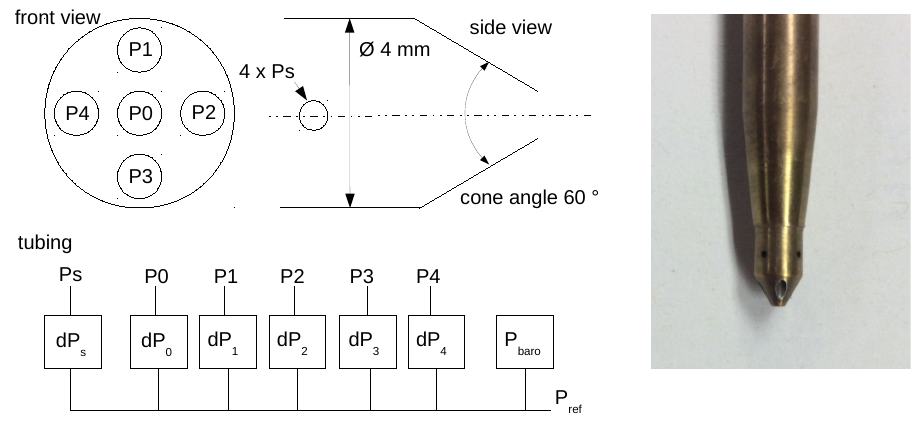
Figure 2. Five-hole probe pressure holes convention, dimensions and tubing schematic ( left ). Picture of the probe tip, used in this study ( right